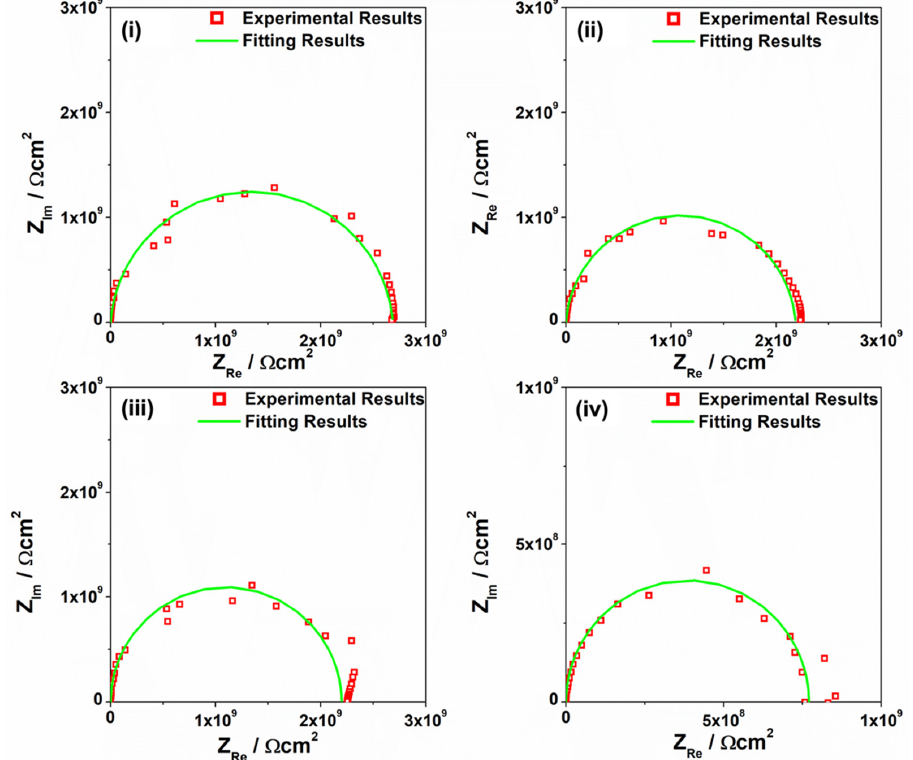
Figure 8. EIS spectra of A(170)_ 3b OIH sol–gel matrices: ( i ) A(170)_ 3b @500; ( ii ) A(170)_ 3b @600; ( iii ) A(170)_ 3b @900; ( iv ) A(170)_ 3b